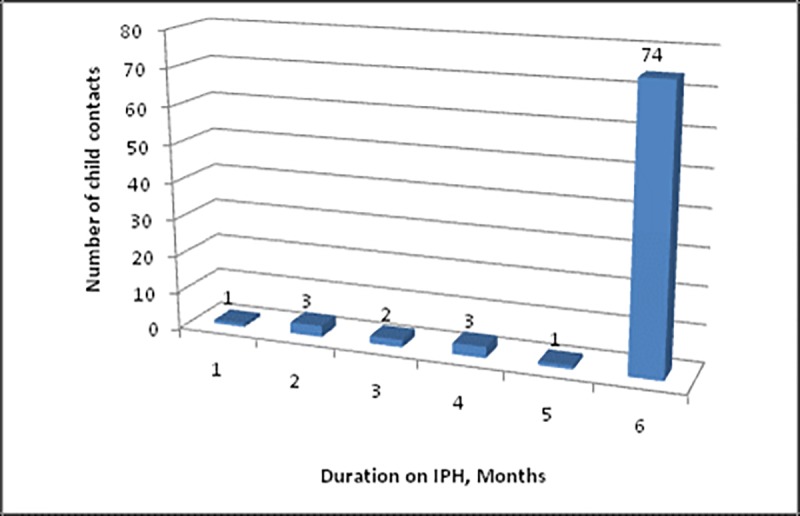
Distribution of number of months IPT prescription was collected.